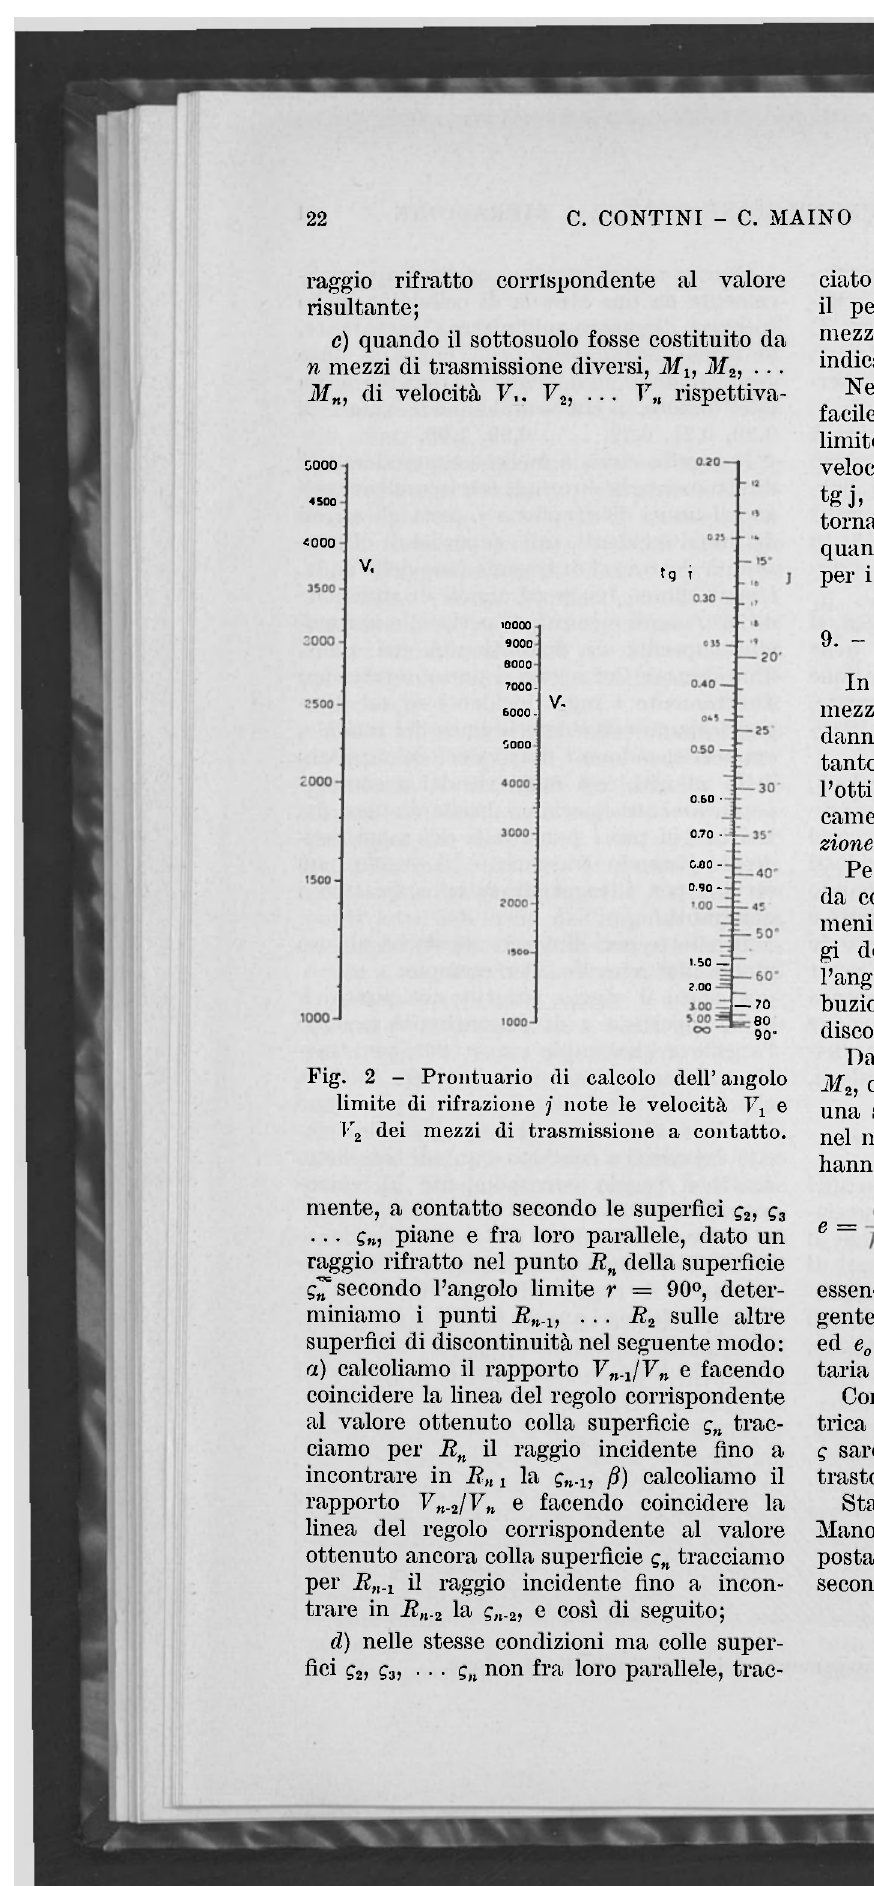
mente, a contatto secondo le superfici g , g 2 3 ... g , piane e fra loro parallele, dato un n raggio rifratto nel punto R della superficie n ^secondo l'angolo limite r = 90°, deter- miniamo i punti R _ .. . R sulle altre n lt 2 superfici di discontinuità nel seguente modo: a) calcoliamo il rapporto F„-i/F„ e facendo coincidere la linea del regolo corrispondente incontrare in 7? la g . fi) calcoliamo il H1 n 17 rapporto